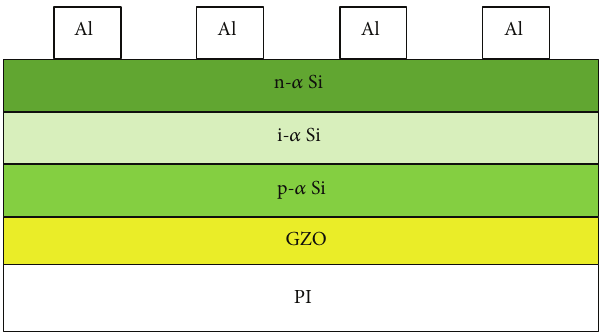
Figure 7: Structure of the superstrate p-i-n 𝛼 -Si:H thin-film solar cells.